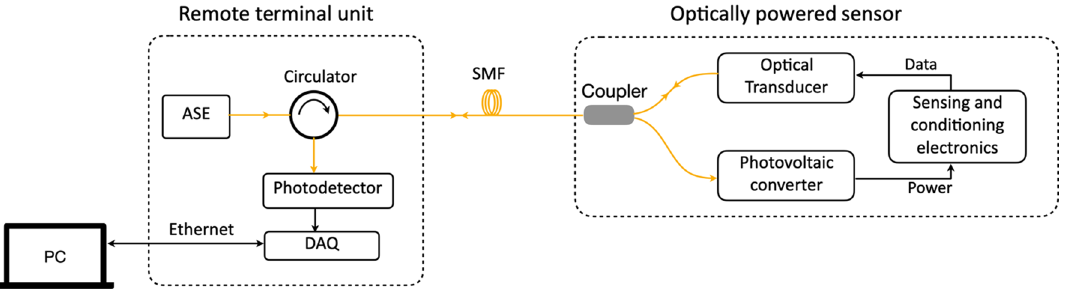
Fig. 1 Block diagram of the approach taken to implement